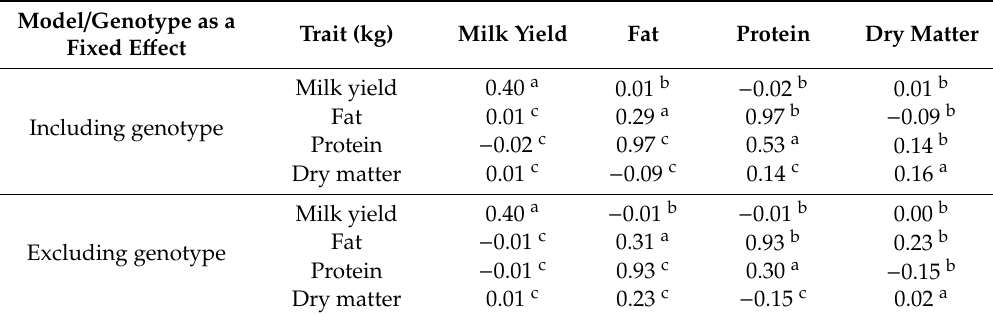
Table 3. Estimated heritabilities (h 2 ) (diagonal), phenotypic (r P ) (above diagonal) and genetic (r G ) (below diagonal) correlations for milk yield, and protein, fat, and dry matter contents (in kg) obtained in bivariate analyses through REML methods in goat milk including and excluding α S1-Casein genotype as a fixed e ff